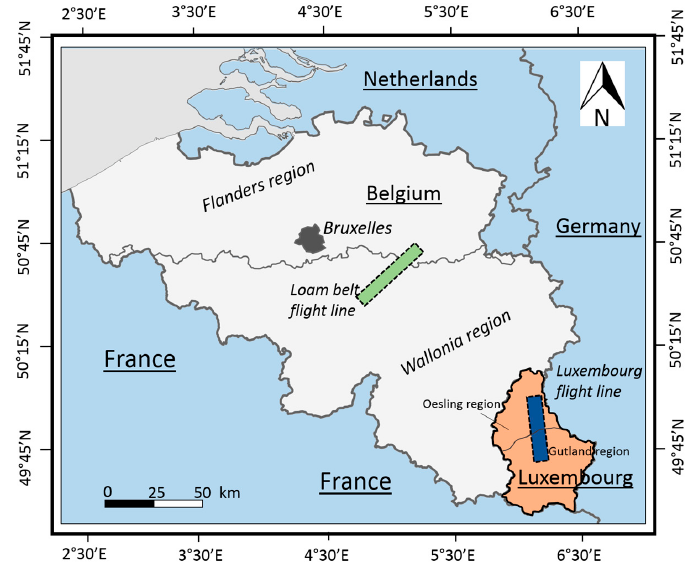
Figure 1. Location of the two study areas in Belgium and Luxembourg over which Airborne Prism Experiment (APEX) data were acquired.